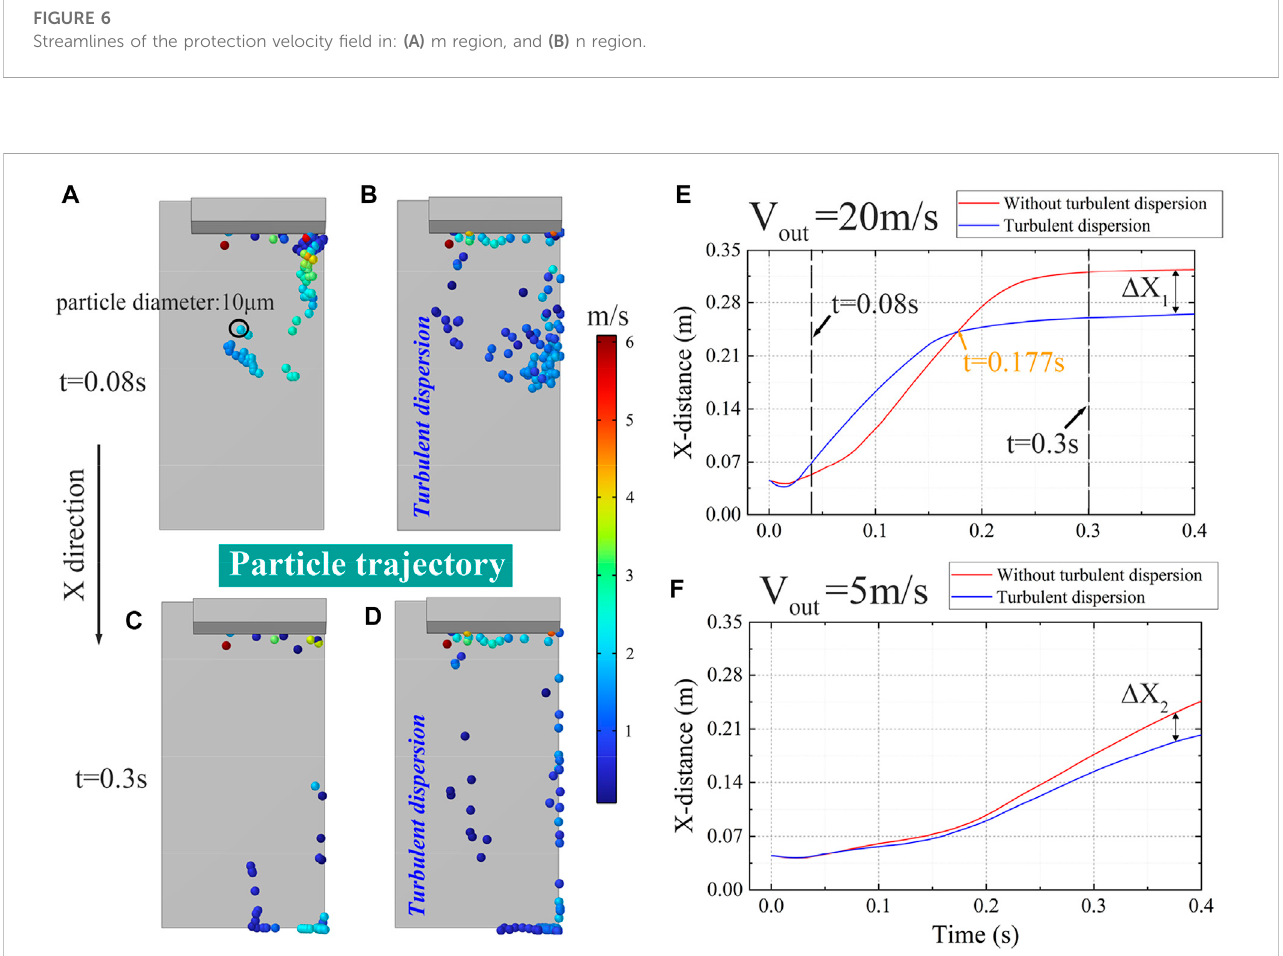
FIGURE 7 (A – D) : Particle trajectories at 0.08 s and 0.3 s, where (B,D) account for the turbulent dispersion during particle motion; (E,F) : X-distance vs. time when the gas knife outlet velocity is 5 m/s and 20 m/s,